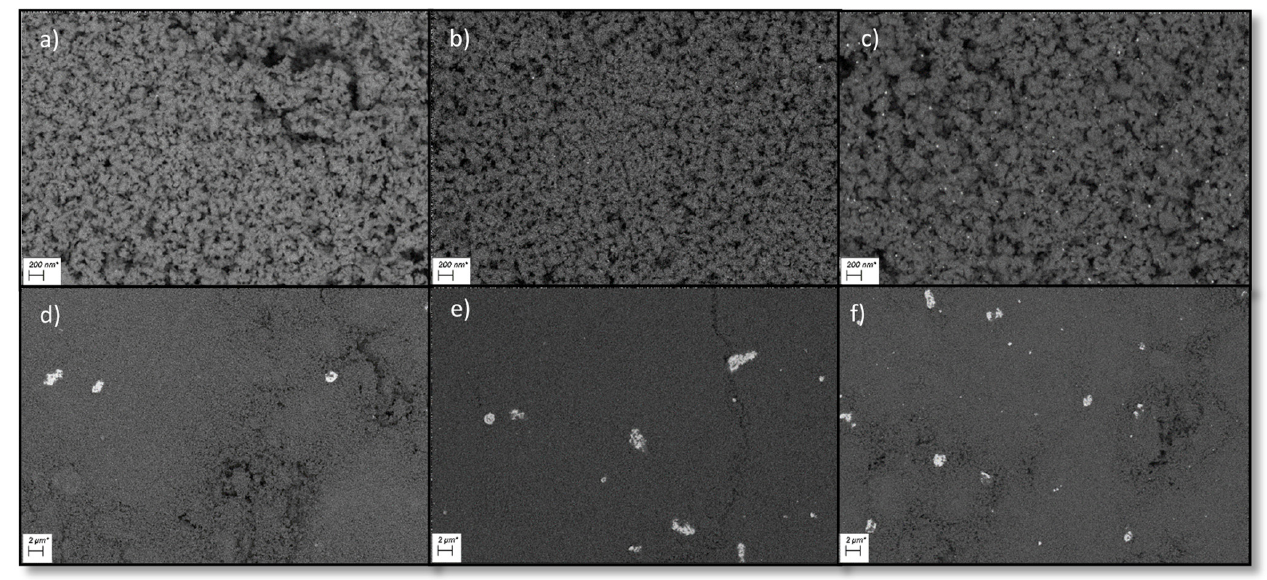
Figure 2. SEM Pictures of all six final Ru on Al 2 O 3 catalysts. ( a ) = Ru-NO-1-icr., ( b ) = Ru-NO-3-icr., ( c ) = Ru-NO-5-icr., ( d ) = Ru-Cl-1-icr., ( e ) = Ru-Cl-3-icr., ( f ) = Ru-Cl-5-icr..